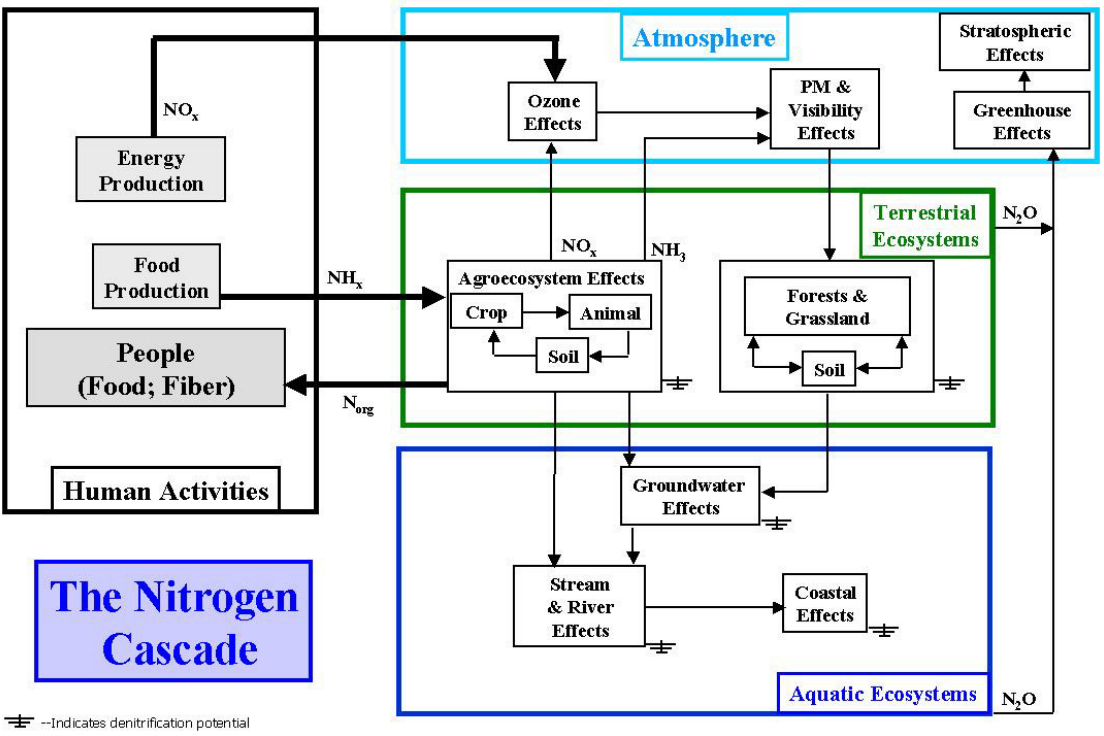
FIGURE 1. The N cascade illustrates the movement of human-produced reactive nitrogen (Nr) as it cycles through environmental reservoirs in the atmosphere, terrestrial ecosystems, and aquatic ecosystems (from plenary presentation by J.